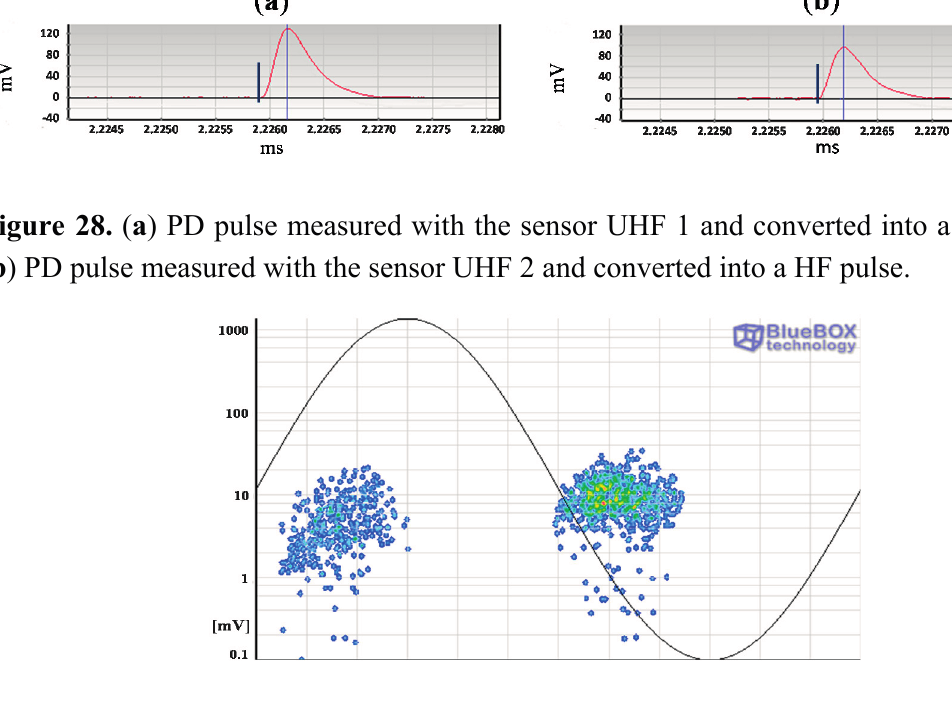
Figure 29. PRPD pattern obtained with the mobile non-invasive UHF sensor coupled in the right termination of position